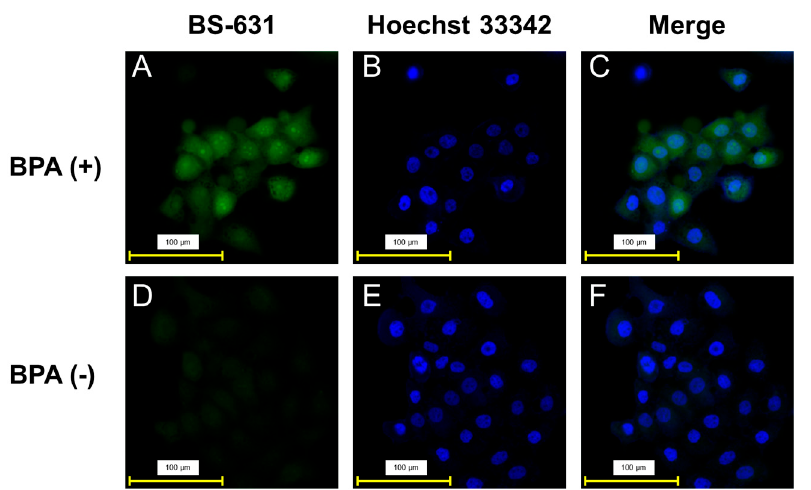
Figure 4. Representative fluorescence images of T3M-4 cells: ( A–C ) BPA-present group, ( D–F ) BPA- absent group. ( A , D ) Fluorescence images after 30 min incubation with BS-631 (100 µM) (GFP filter: Ex: 470/40 nm, Em: 525/50 nm). ( B , E ) Nucleus staining using Hoechst 33342 (DAPI filter: Ex: 360/40 nm, Em: 460/50 nm). ( C , F ) Merged images of fluorescence from BS-631 and Hoechst 33342.